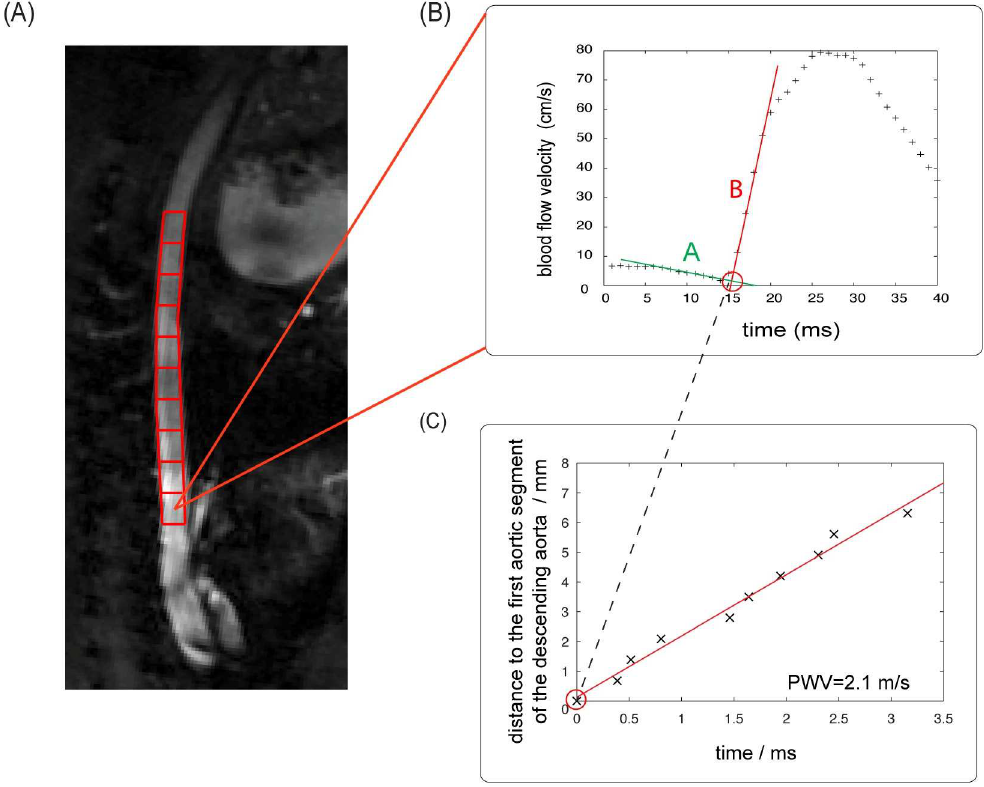
Fig 4. Determination of global PWV. In vivo determination of globalpulse wave velocity (PWV) with the multi- point transit-time method in the descending aorta of a wild type mouse ( A-C ). Ten evenly spaced segments for the globalPWV measurements (red) and the derived flow curves are shownin a magnitude image of a PC-Cine- FLASH scan ( A ). In each segment ( B ), the arrival time of the pulse wave is determined in the flow curve as the intersection point of the pre-systolic baseline( A, green ) and the systolic upslope( B, red ). The slope of the linear fit ( C ) of distanceover the accordingpulse wave arrival times represents the globalPWV.